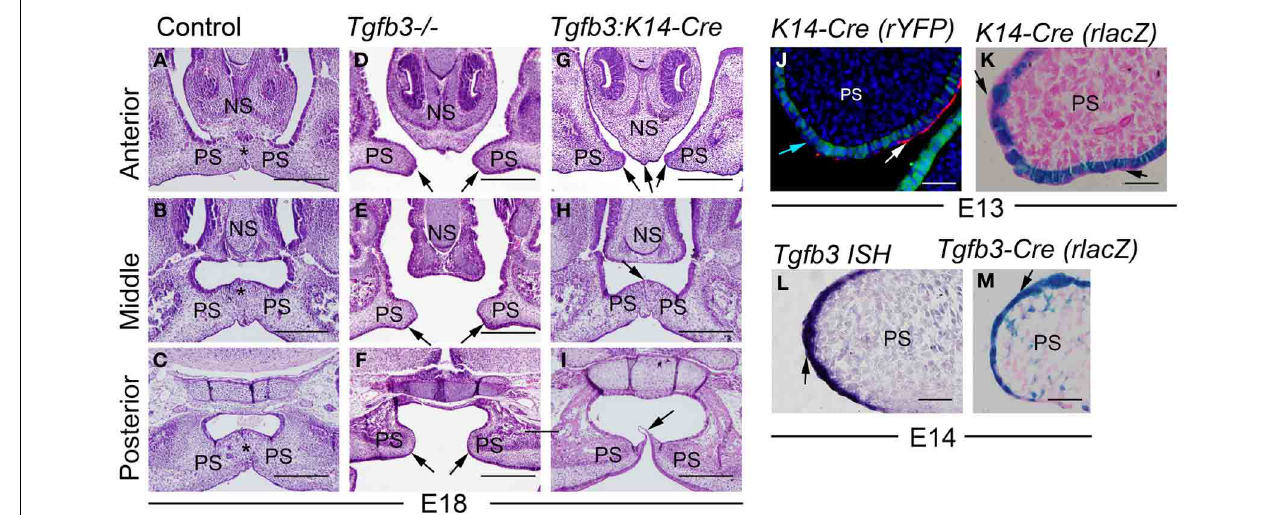
FIGURE 1 | Milder palatal phenotype of epithelium-specific Tgfb3:K14-Cre mutants than that of Tgfb3 null mutants results from an inability of K14-Cre to recombine in peridermal cells. (A–C) control; (D–F) Tgfb3 − / − mutant; (G–I) , Tgfb3:K14-Cre ( A–I , frontal orientation; all at E18). (A,D,G) on the level of the nasal septum (anterior); (B,E,H) , mid-eye level (middle); (C,F,I) on the level of soft palate (posterior). Asterisks in (A–C) indicate confluent midline mesenchyme, black arrows in (D,E) point to unfused palatal shelves, black arrows in (G–I) point to unfused elements of the anterior palate (G) , a persistent epithelial seam in the mid-palate (H) , and an epithelial bridge in the posterior soft palate (I) . (J) a frontal palatal section of a K14-Cre:R26R-YFP embryo at E13; double immuno-fluorescence staining to detect YFP-positive recombined cells